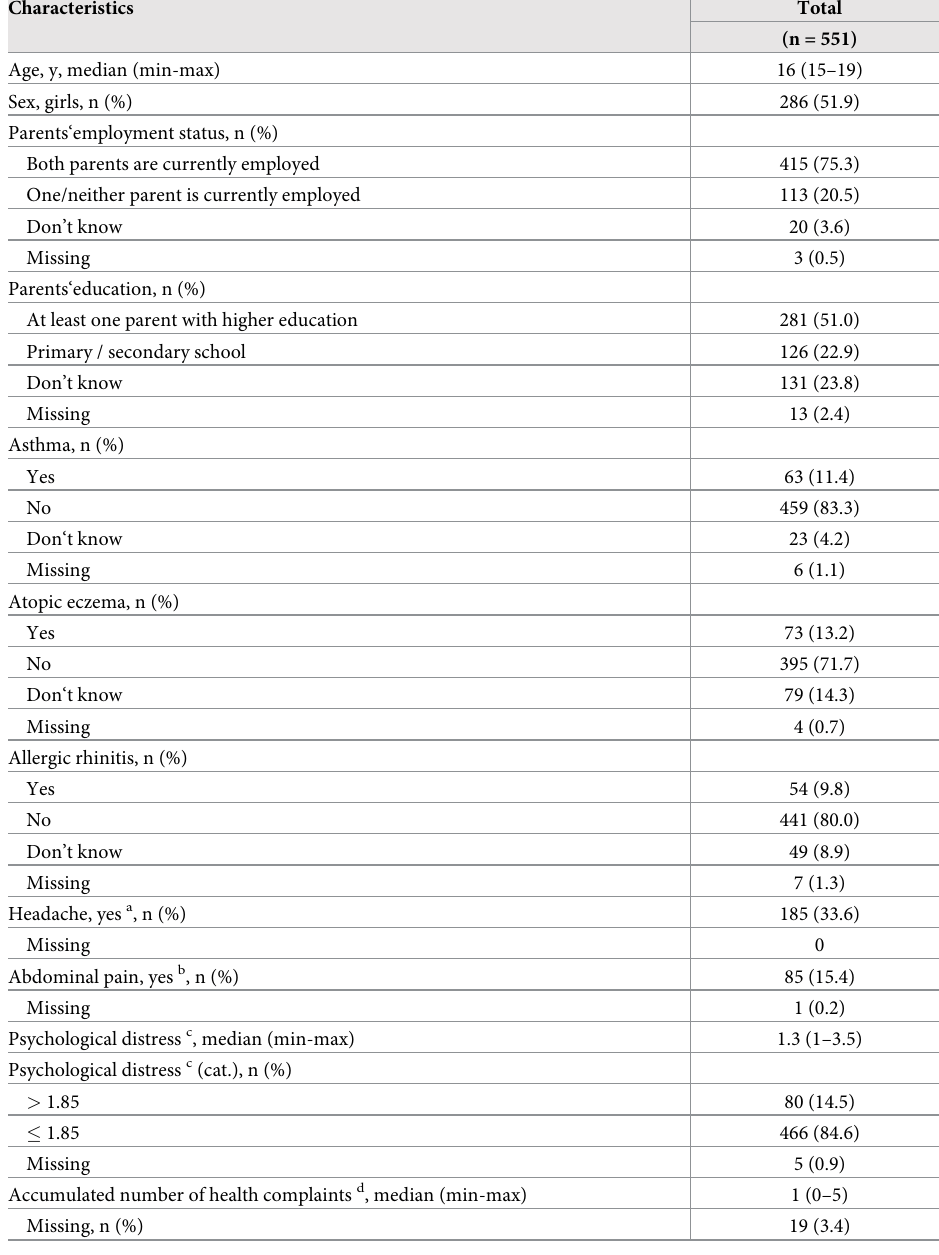
Table 1. Baseline characteristics of the study